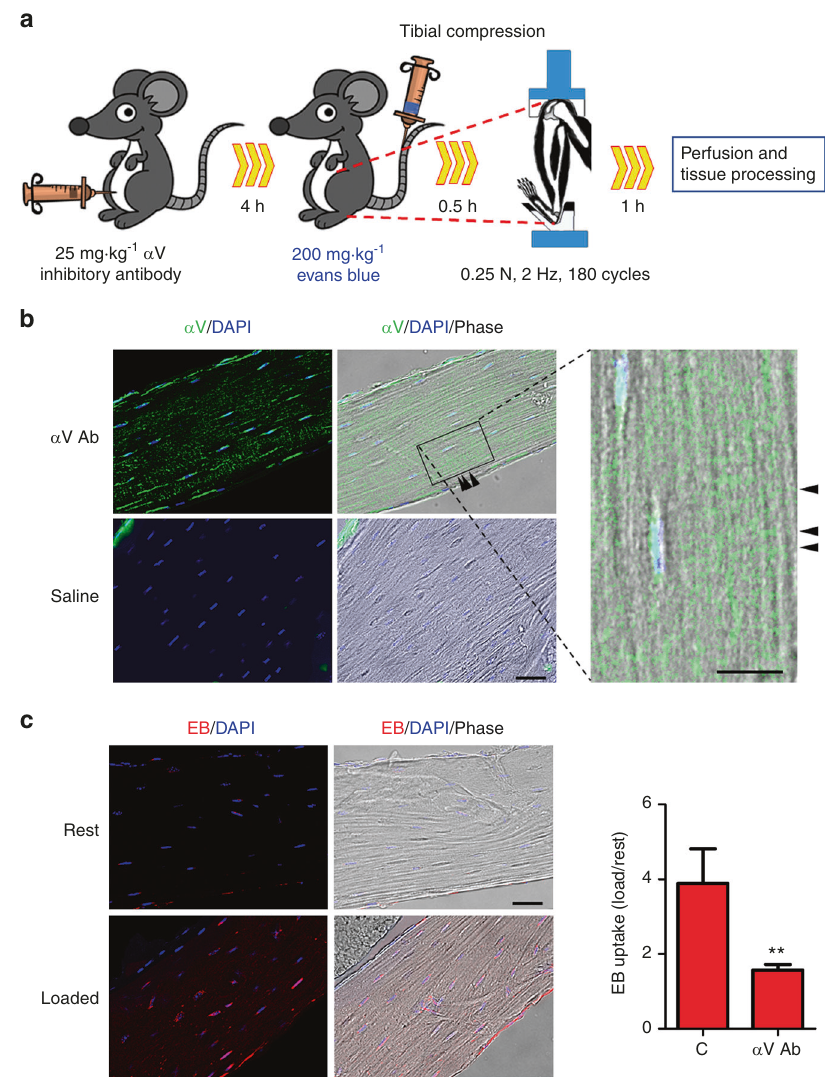
Fig. 5 Integrin α V activation is required for osteocyte HC opening in vivo. a Schematic model of tibial compression in mice treated with an anti- α V inhibitory antibody. The antibody was IP injected 4 h before Evans Blue was IV injected. Tibial compression was conducted in WT mice injected with or without an antibody. b The anti- α V inhibitory antibody distribution in the bone was traced using Alexa 488-conjugated anti- Armenian hamster IgG. Bar, 50 µm. The 4.5X ampli fi cation of the image shows the reactivity distribution striated around the osteocyte dendrites (right panel, arrowheads). Bar, 25 µm. c Inhibition of osteocyte HC opening by an anti- α V inhibitory antibody. Evans blue uptake was evaluated by fl uorescence signals (left panel). Bar, 50 µm. The intensity of dye uptake in osteocytes was quanti fi ed by ImageJ (right panel). The data are presented as the mean ± SEM. n = 3. **, P <